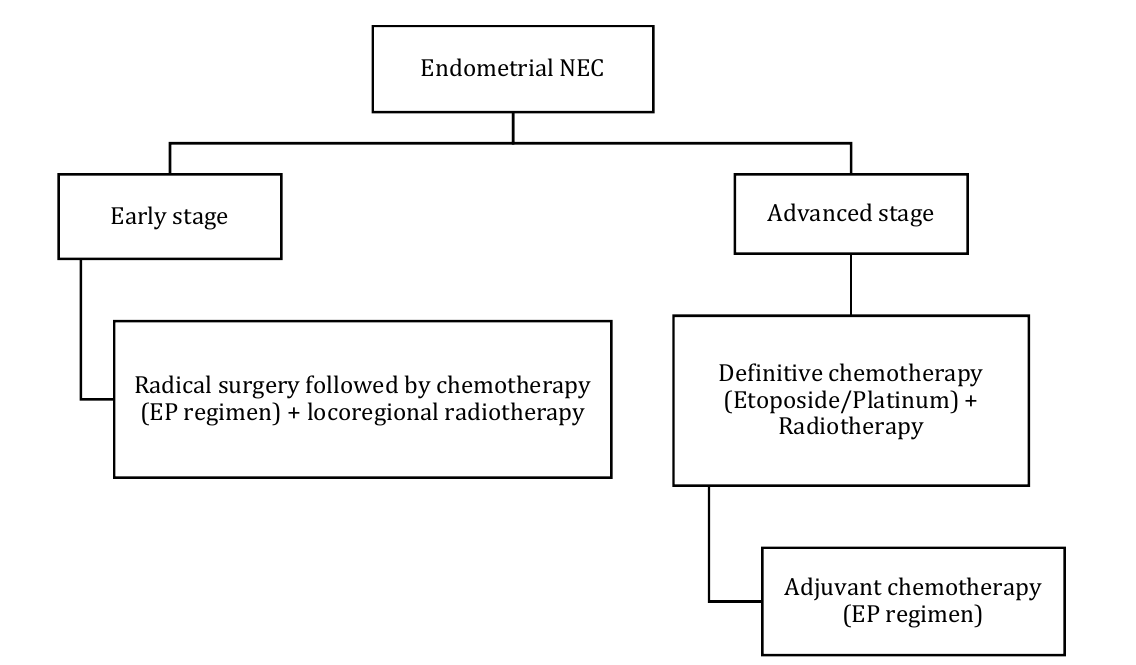
Figure 13. Treatment algorithm of endometrial NEC. If non-surgical or metastatic disease: palliative chemotherapy with EP regimen or enrollment into clinical trials.